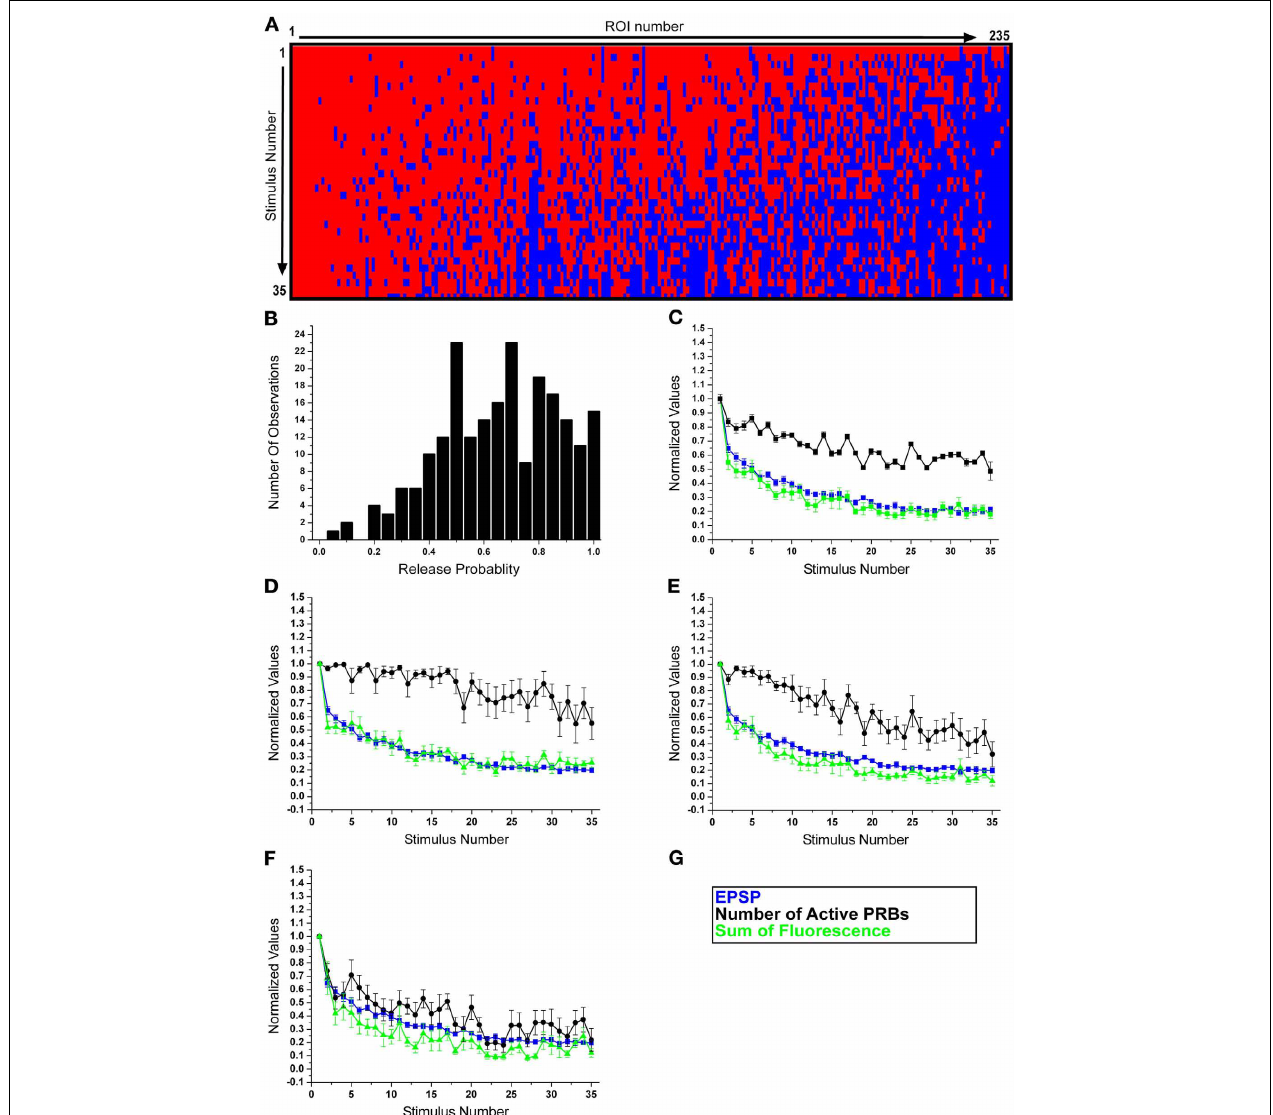
FIGURE 3 | Subdivision of the release boutons into three phenotypes. (A) A raster plot of all EPSCaTs (corresponding to 235 release boutons documented in this study). Red depicts a release event, blue failure of release to occur. Boutons revealing consistent release over the 35 stimuli are depicted on the left hand side of the graph, and those that revealed failures to release within the first 10 stimuli are grouped on the right side of the graph. (B) The histogram depicts the normalized EPSCaT (cid:2) F / F values of 235 PRBs over 35 presynaptic stimuli at 0.05Hz. Note the peaks around 0.5, 0.7, and 0.80. (C–F) Normalized data from 10 experiments. In blue the normalized EPSP amplitudes, in green the normalized sum of EPSCaTs of the PRBs and in black the normalized number of active PRBs as a function of the stimulus number. (C) Note that the overall average decline kinetics of the EPSPs amplitude and all EPSCaTs reveal similar kinetics. After 35 stimuli both EPSPs